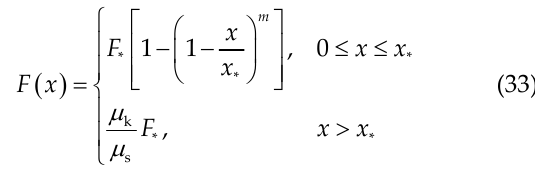
 x x . Effect of the different static and 0 *    ) on the variation of the s k  x x . 0 *